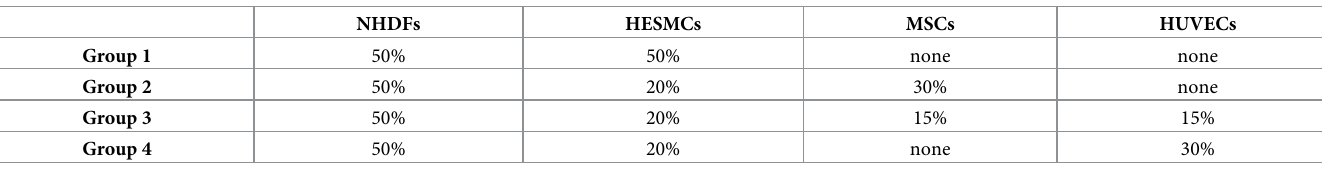
Table 1. Cell compositions of